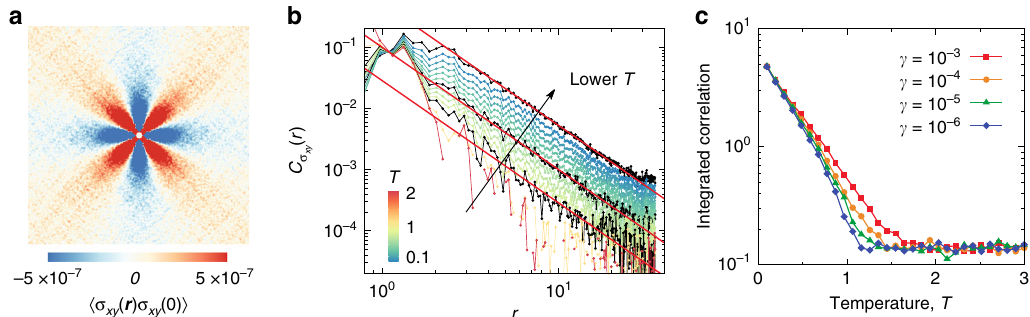
Fig. 1 Long-range stress correlation at fi nite temperatures. a Spatial correlation of shear stress σ xy at T = 0.1. b Angle-averaged shear-stress correlation C ð r Þ at temperatures covering both liquid and solid regimes. The ensemble of con fi gurations is generated by a constant cooling rate γ = 10 − 5 . The data σ xy colour changes from red to blue with a decrease in T . Three sets of data are highlighted in black colour, which, from top to bottom, correspond to T = 0, the hypothesized ideal glass transition temperature T 0 ≈ 0.63, and slightly below the glass transition temperature T g ≈ 1.3. The red solid lines are fi ts to the power-law function of 1/ r 2 , indicating the emergence of the long-range correlation below T g . c Temperature dependence of integrated shear-stress correlations for different cooling rates γ . The γ -dependent non-equilibrium glass transition is signalled by the onset of the growth of shear stress correlation (see Fig. 5 below for the corresponding analysis of shear modulus). See text for detailed de